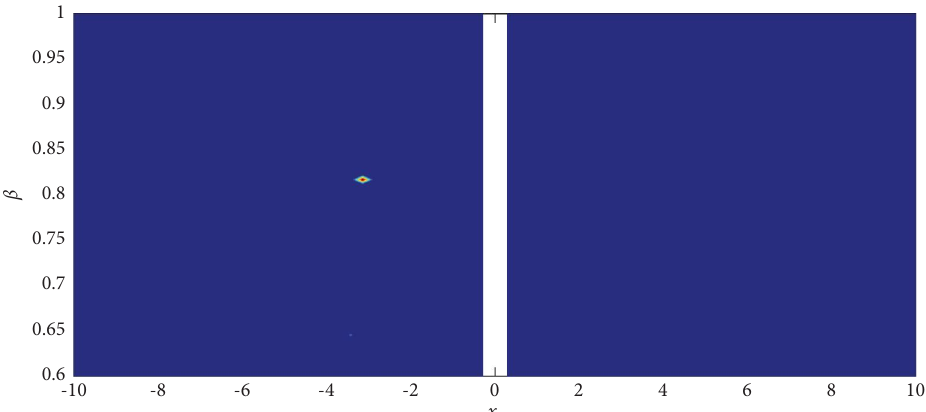
Figure 7: Convergence planes of frst-order NR on f